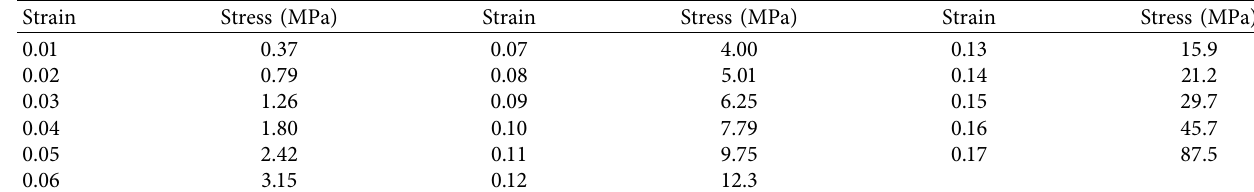
Table 2: Stress-strain relation of rock mass in the double-yield model goaf.